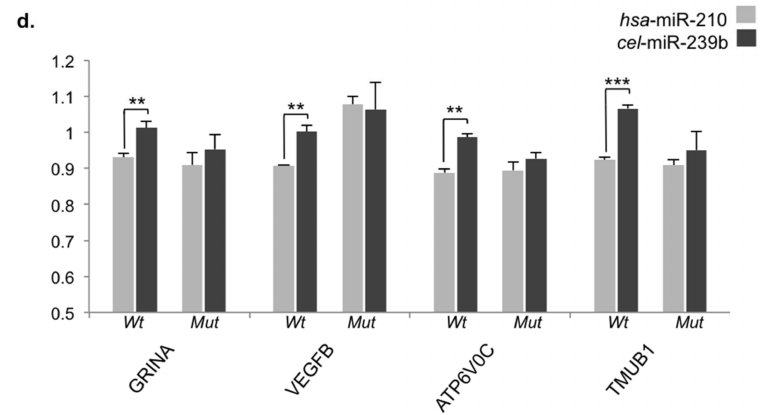
Figure 2. Dual-luciferase assay validation of miR-210 target regulation. ( a – d ) Measured Renilla-firefly luciferase ratios of target region/ Ψ Check2 vector constructs transfected into Cos-7 cells alone or in combination with hsa-miR-210 mimic of cel-miR-239b negative control mimic, normalized to native Ψ Check2 and plasmid-only values. ( a ) 3 (cid:48) untranslated regions (UTRs) of neuronal/synaptic plasticity genes; ( b ) 3 (cid:48) -UTRs of cancer-related mTOR/VEGF signaling pathway genes; ( c ) 3 (cid:48) UTRs of metabolic pathway genes; ( d ) Short microRNA recognition elements (MREs) in predicted target gene 3 (cid:48) UTRs ( Wt ) and mutated MRE sites ( Mut ). Y -axis = Renilla-firefly luciferase ratio in all graphs; error bars represent standard error; * p < 0.05, ** p < 0.01, *** p < 0.001; n = 4 biological replicates, two sample t